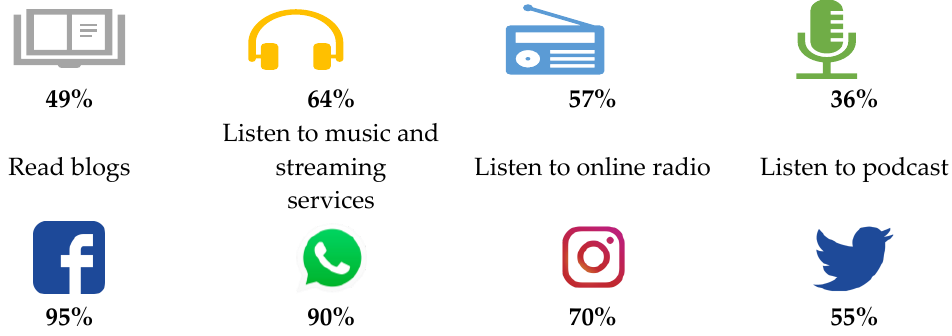
Figure 2. Presence of Colombians on social networks and content they consume on the network.